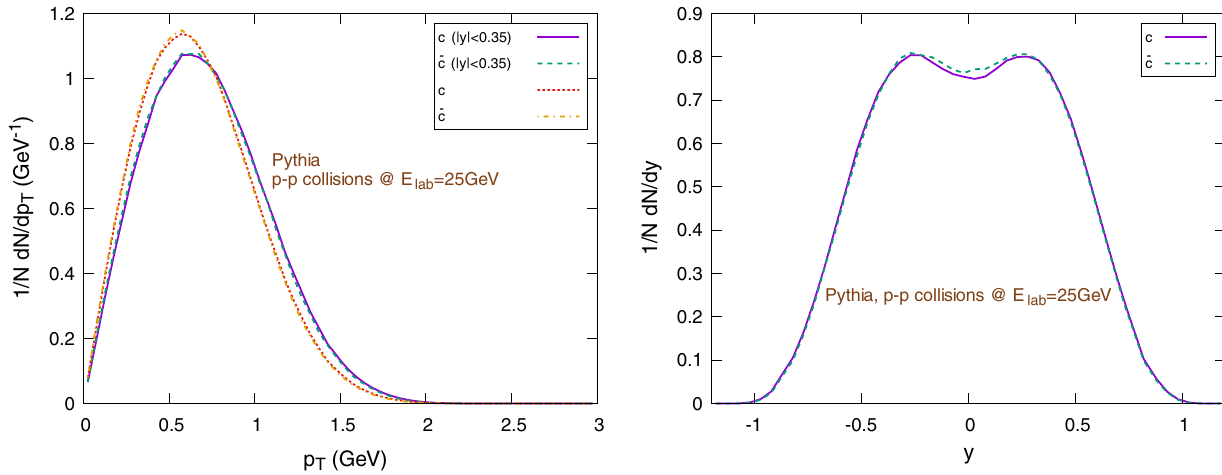
Fig. 8 Spectra of initial charms and anti-charms as sampled with Pythia. The left figure shows the (normalized) 1 / N d N / d p T distribution (in the rapidity range | y | < 0 . 35), the right figure shows the (normalized) 1 / N d N / d y distribution